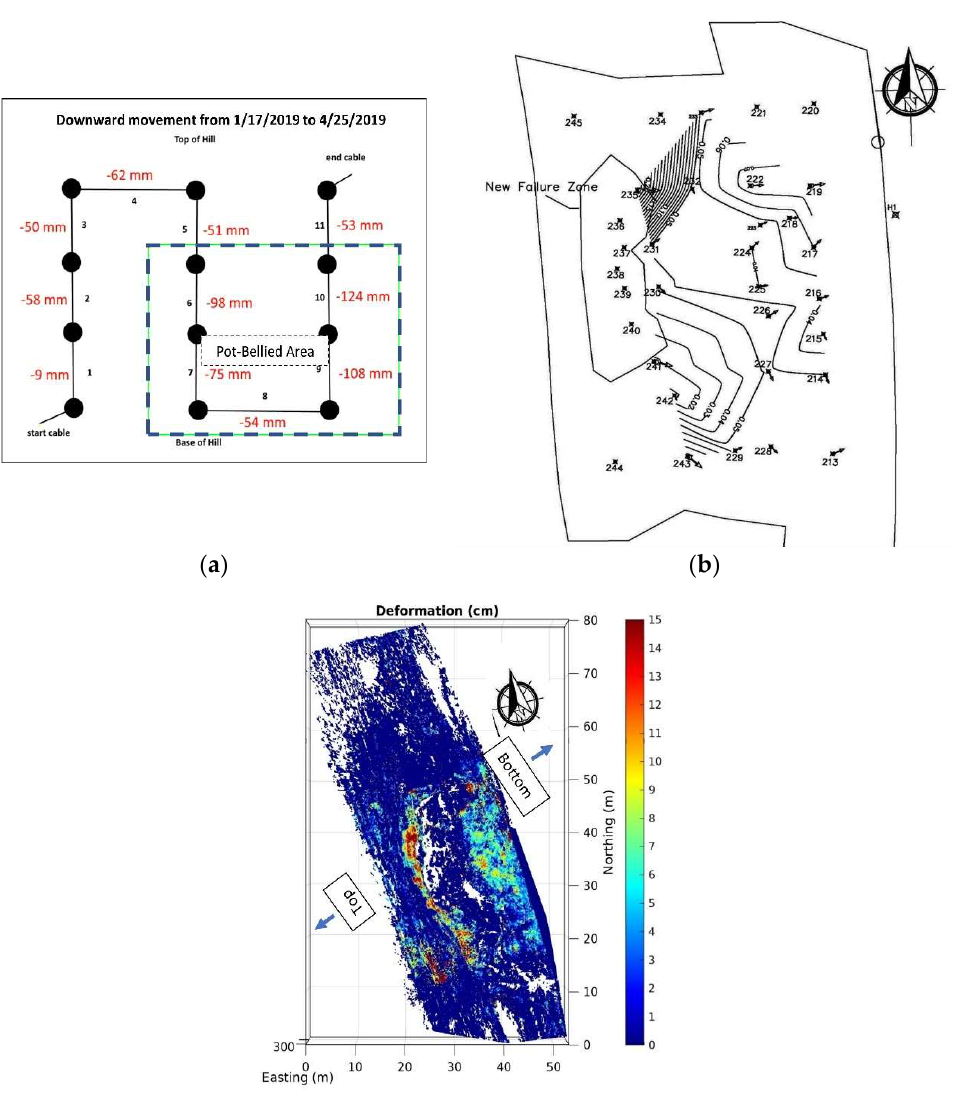
Figure 9. Deformation profiles of I-180 slope obtained from different methods. ( a ) Downward deformation monitored by DSS. Note: (100 mm = 2.5% downward strain) ( b ) Deformation (m) contour measured by TS (Difference between before and after the failure. Arrows indicate the direction of the movement). ( c ) Deformation profile from the UAS-based method (Unit of the color bar is in